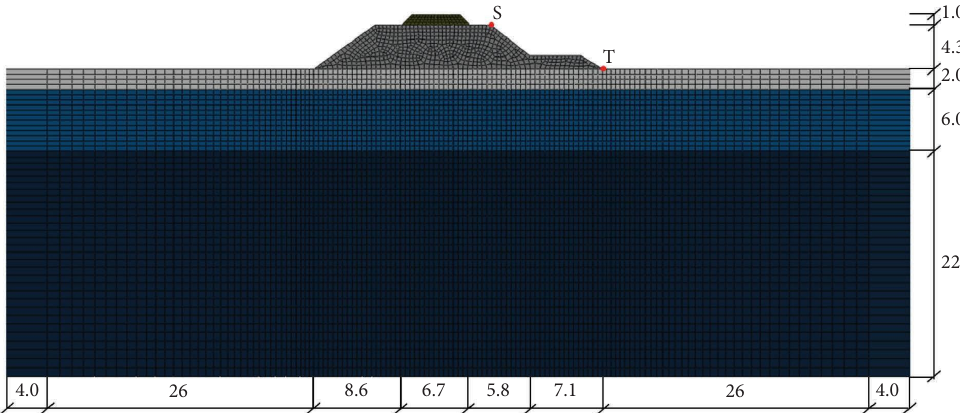
Figure 3: Te full-scale numerical model of a typical traditional embankment (unit: